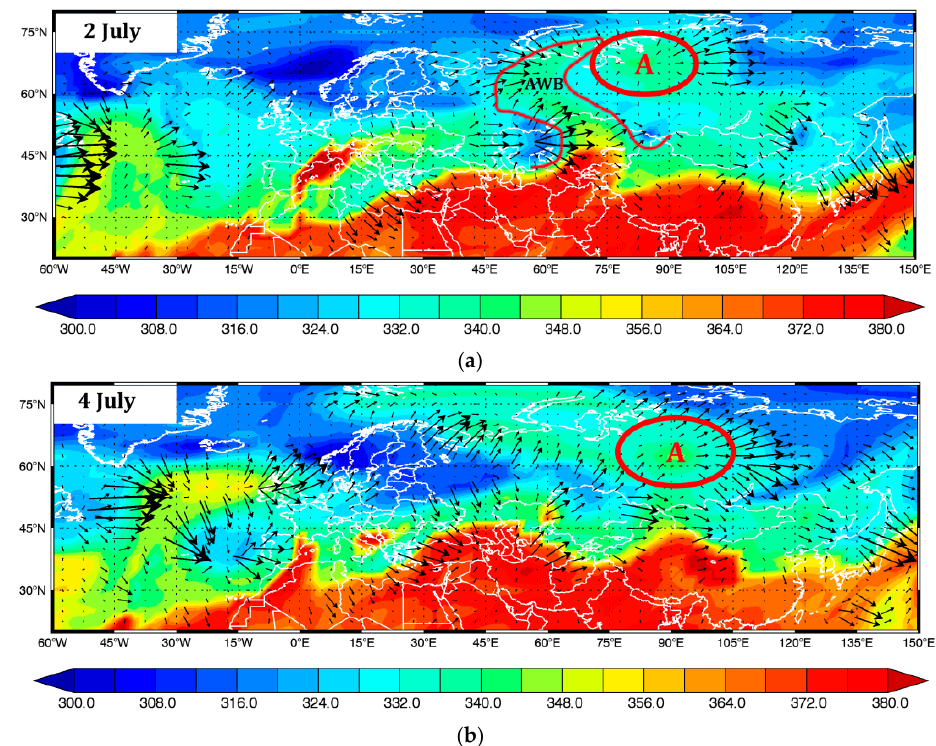
Figure 9. Circulation pattern (WAF and PV- Θ, similar to Figure 4) on 2 ( a ) and 4 ( b ) July (3rd period. Here and below, a red circle with the letter “A” marks the position of the blocking anticyclone (according to maps of geopotential at 500 hPa). Era-Interim data.